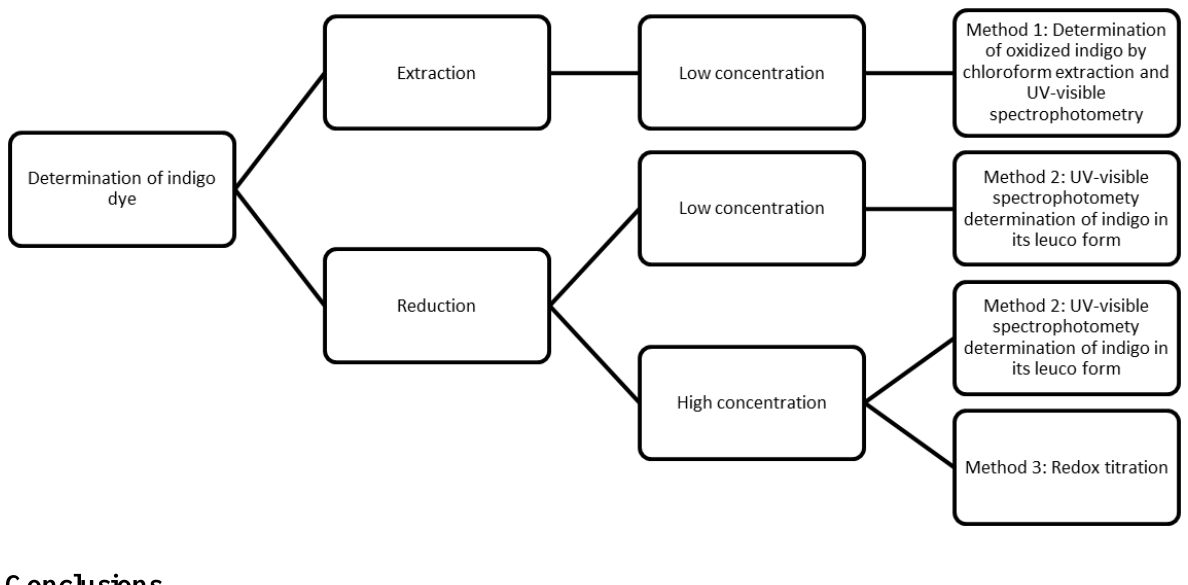
Figure 2. Scheme of the studied methods and their